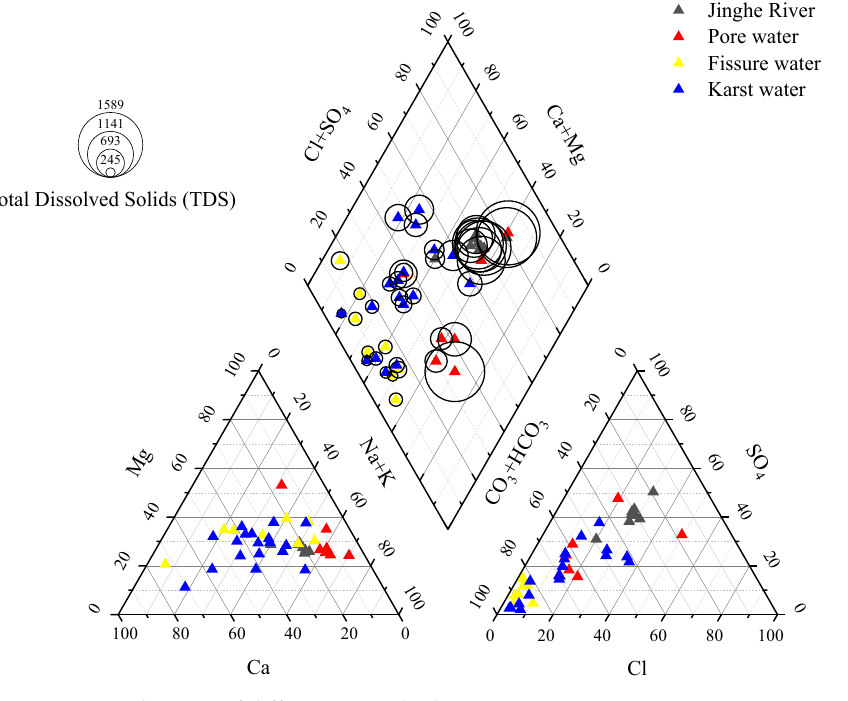
Figure 2. Piper diagram of different water bodies.